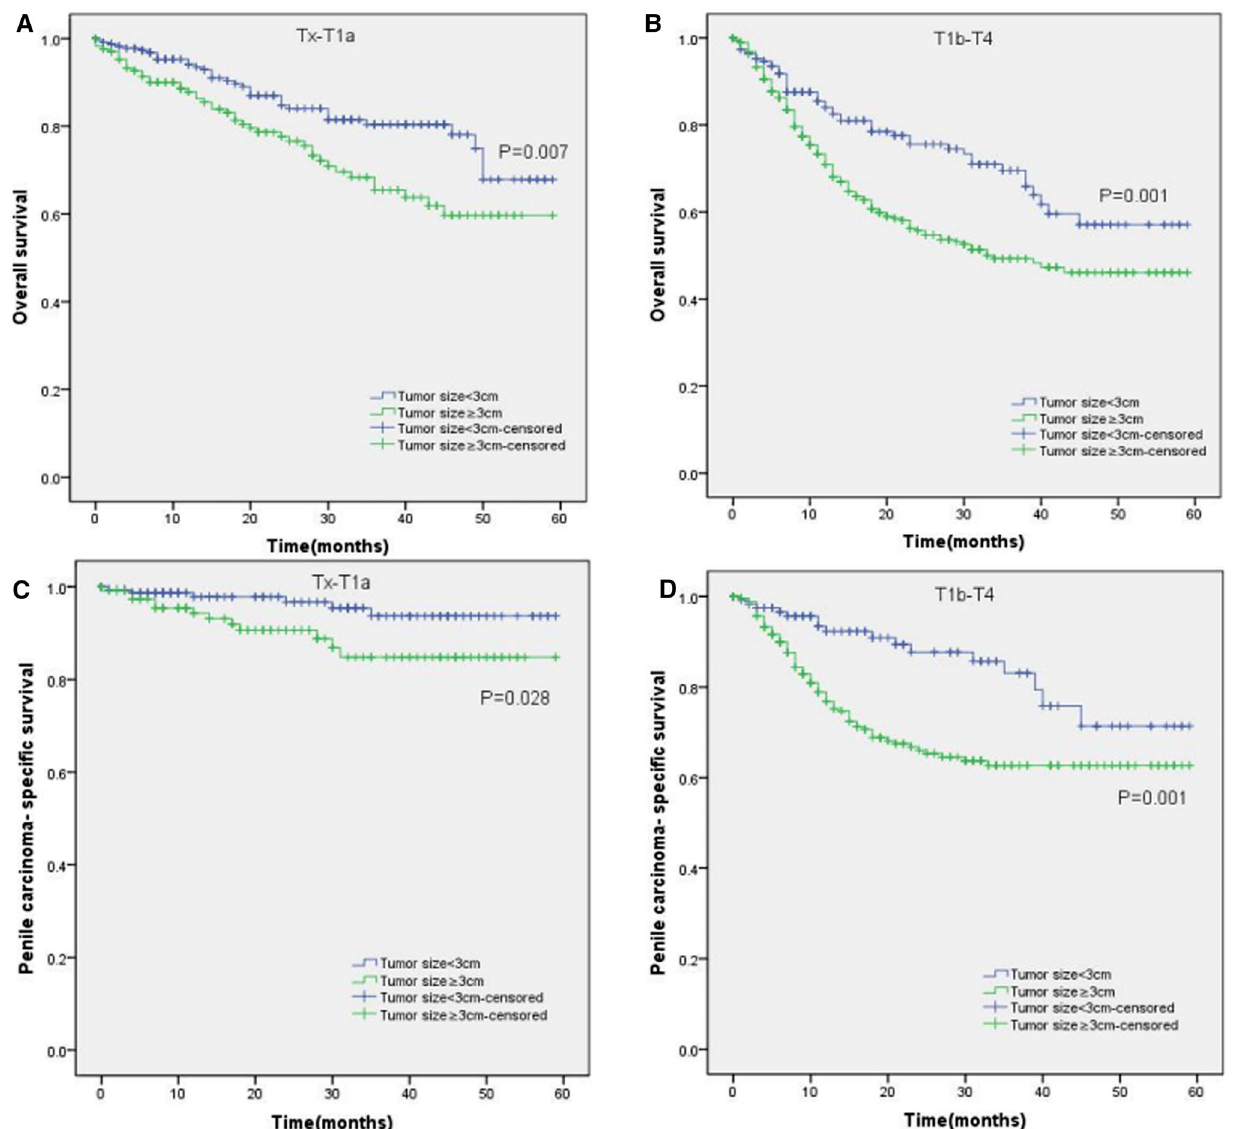
Fig. 4 Kaplan–Meier analyses of overall survival ( A , B ) and penile carcinoma-specific survival ( C , D ) between Tx–T1a group and T1b–T4 group in patients stratified by tumor